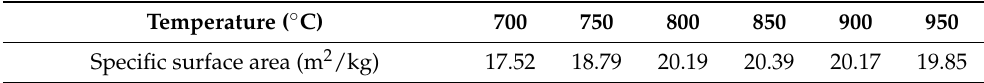
Table 7. Brunner–Emmet–Teller (BET) surface area of products.